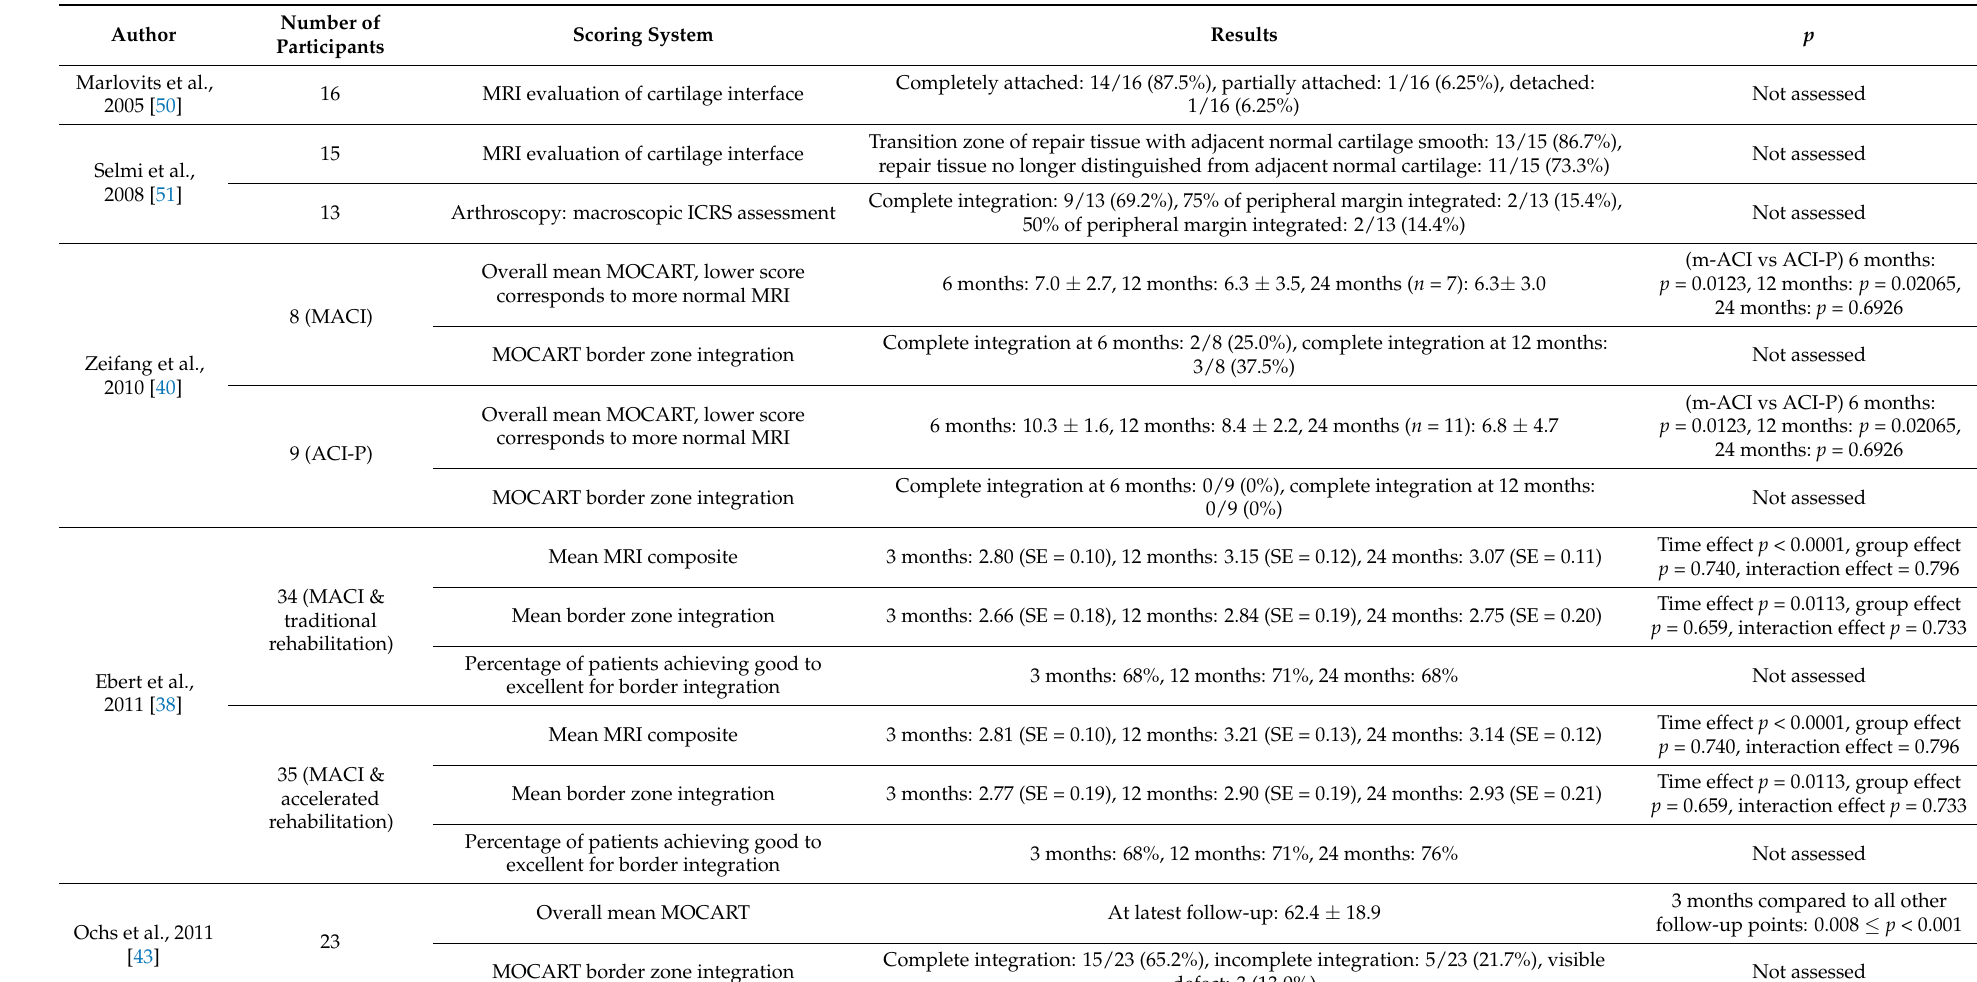
Table 3. MRI, Arthroscopic and Histological assessments of